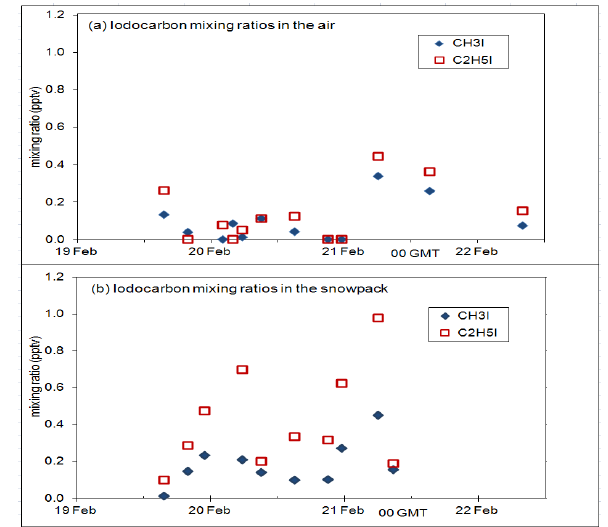
Fig. 13. Iodocarbon concentrations measured (a) in overlying air and (b) by drawing air through a Teflon-lined tube pushed 20 cm into the snowpack, on the Brunt Ice Shelf.